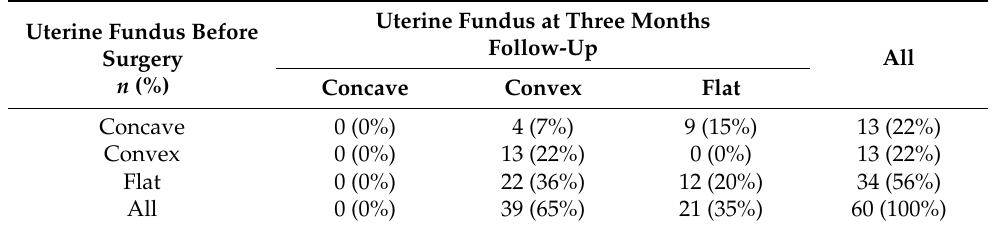
Table 2. Shape of the uterine fundus before surgery and at three-month evaluation after surgery. Uterine Fundus Before Surgery n